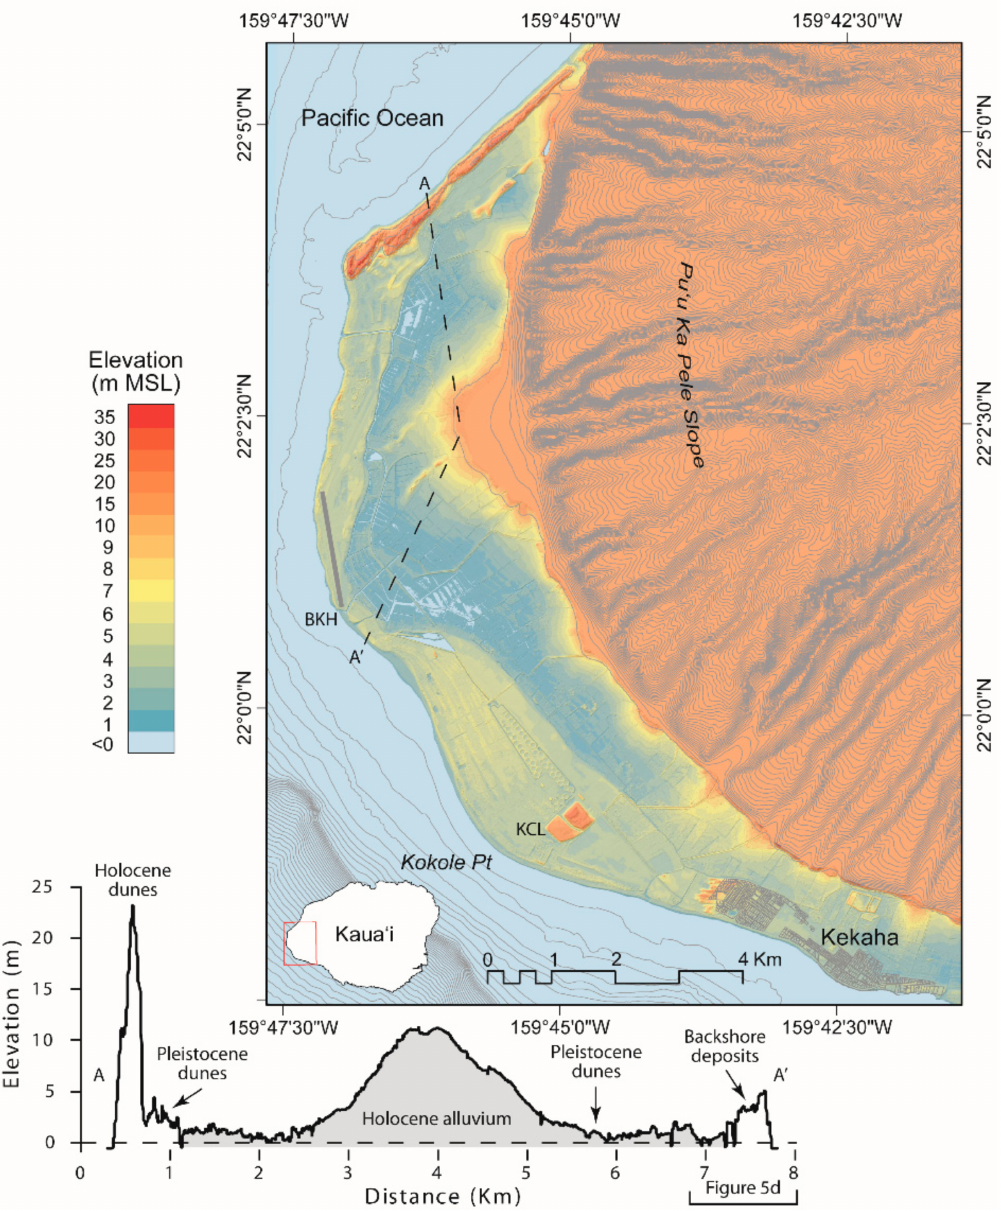
Figure 1. Topography of the M¯an¯a Plain and adjacent areas (location is indicated by red rectangle in inset map). This segment of the NOAA Coastal Services Center’s hydro-flattened, 3 m DEM was developed from 2006 Hawai‘i FEMA Lidar. It is referenced vertically to the local mean sea level tidal datum (MSL, with vertical units of meters) and horizontally to the North American Datum of 1983 (NAD83), and is superimposed upon the University of Hawai‘i’s School of Ocean and Earth Science and Technology (SOEST) Kaua‘i hillshade. The unlabeled 10 m nearshore bathymetric and elevation contours on Pu‘u Ka Pele Slope were derived from SOEST’s 50 m bathymetry and topography grid for the main Hawaiian Islands, and call attention to changes in the elevation and shape of the adjacent terrain. The location of section A–A’ is shown by the dashed line. In addition to the irrigation and drainage ditch systems, prominent anthropogenic topographic features on the M¯an¯a Plain include the runway (BKH) at the 8.64 km 2 U.S. Navy’s Pacific Missile Range Facility and the Kaua‘i County landfill